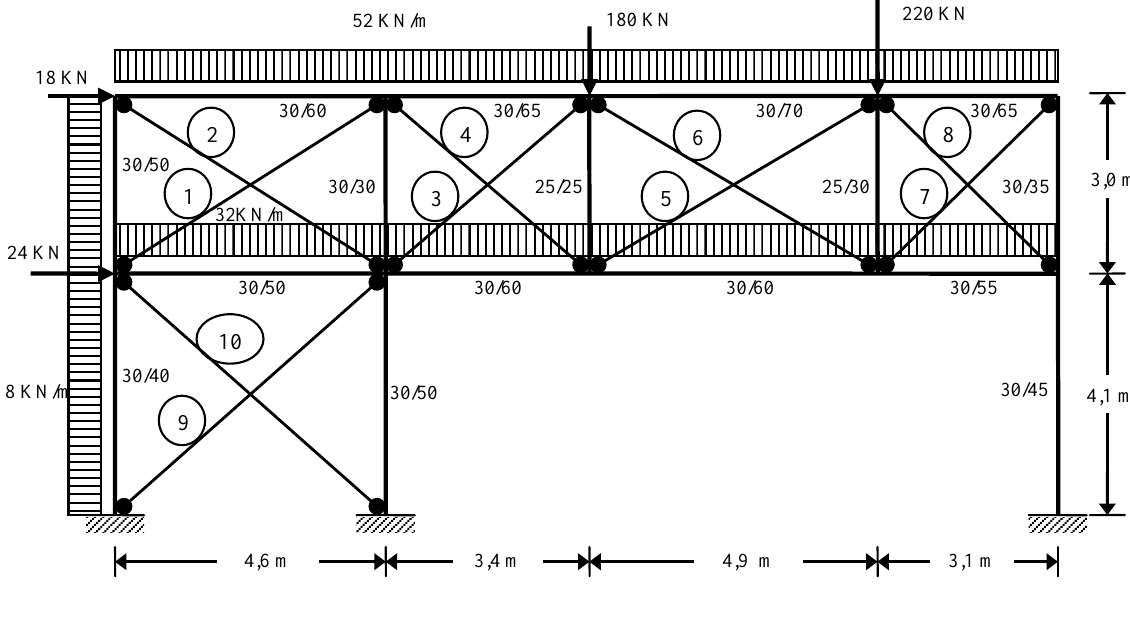
Fig. 1. The cable-braced structural system of the numerical example.